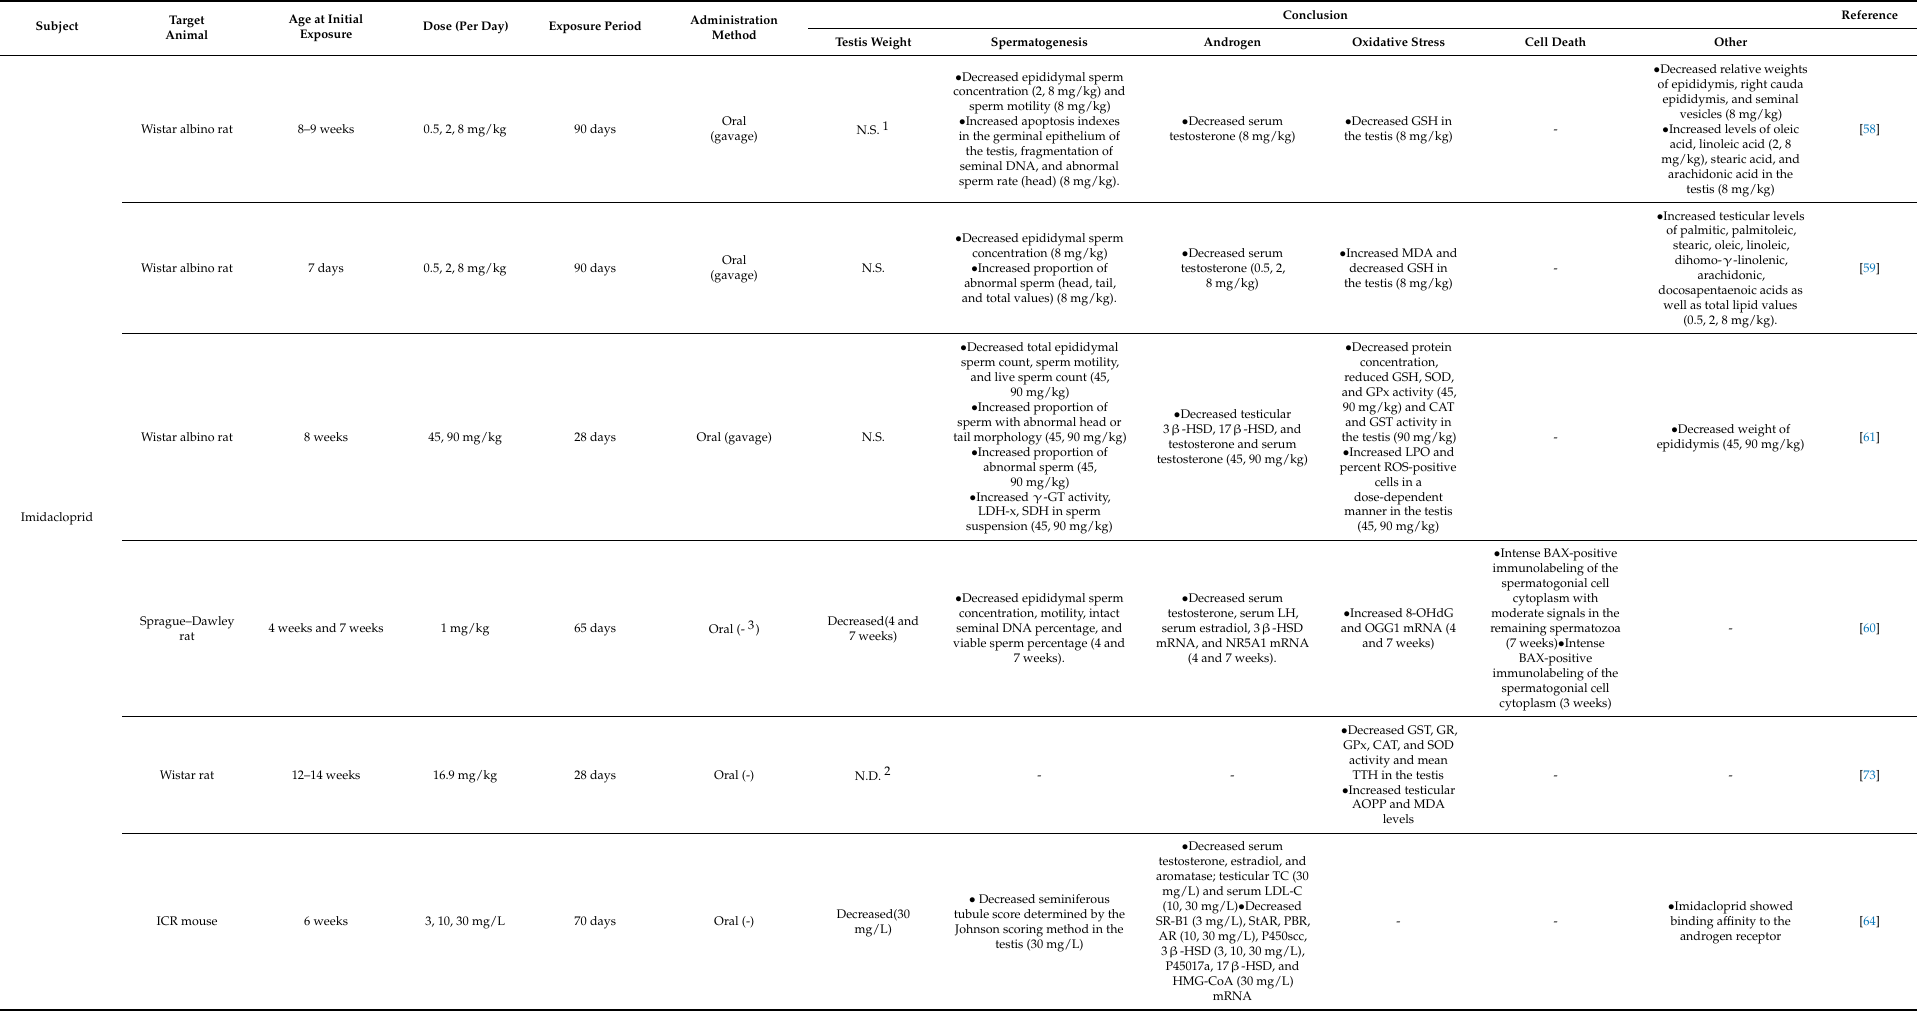
Table 3. Various effects of neonicotinoid pesticides determined in previous reports on